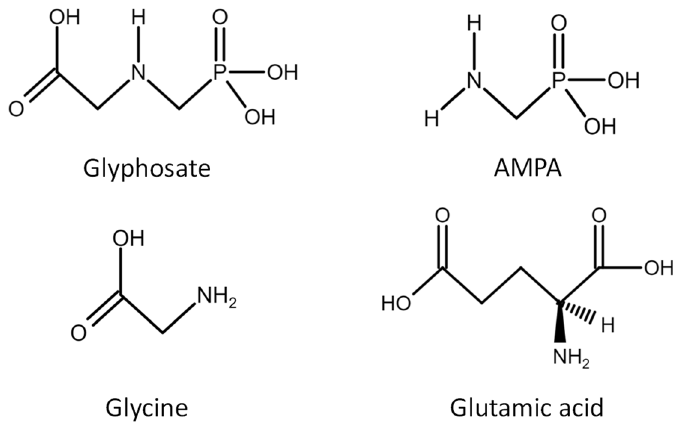
Figure 2. Chemical structures of glyphosate and its co-genres: aminomethylphosphonic acid (AMPA), glycine and glutamic acid.